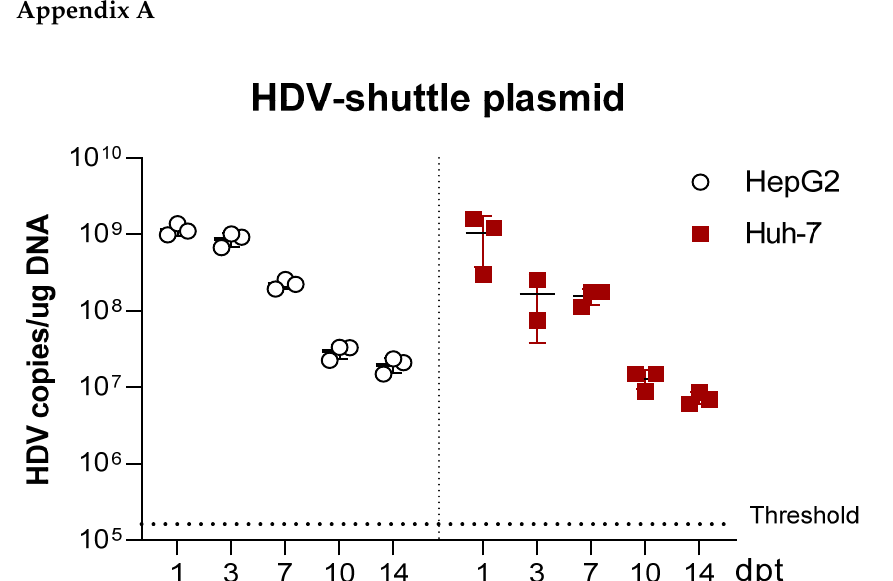
Figure A1. The levels of shuttle plasmid containing the HDV antigenome decrease over time coinciding with cell division. Total DNA was extracted from HepG2 and Huh-7 cells and HDV DNA copies were quantified by qPCR.